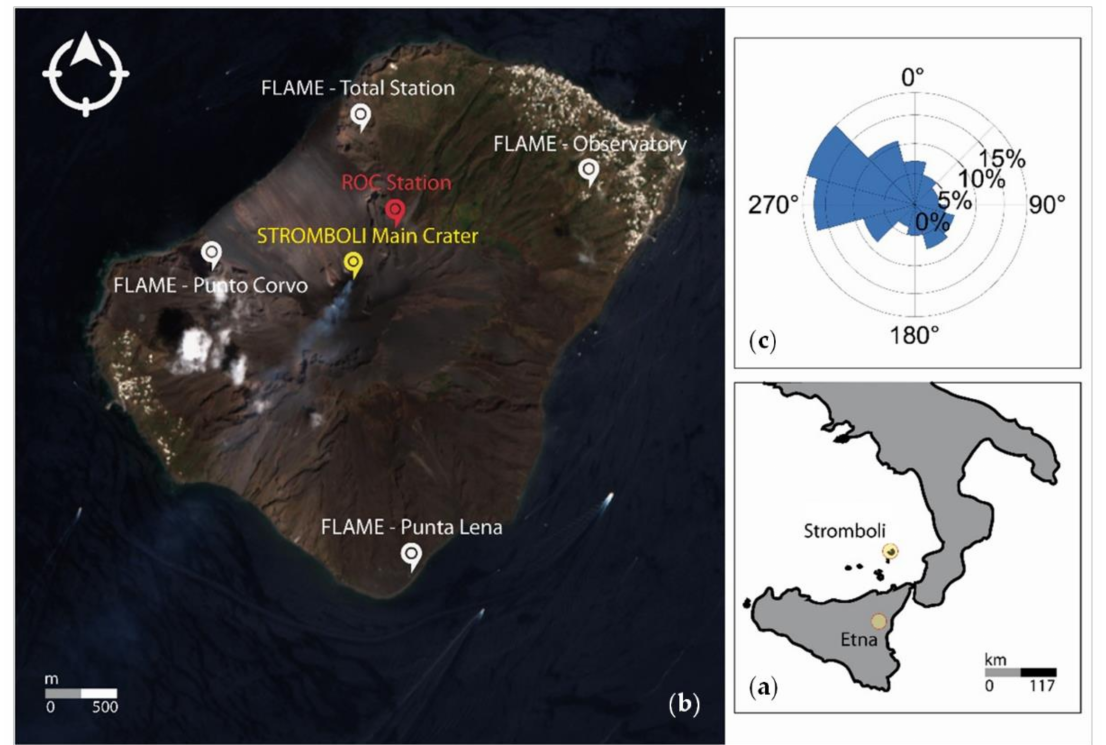
Figure 1. ( a ) Location of the Stromboli volcano in southern Italy and ( b ) satellite overview of the volcano edifice from Copernicus Sentinel-2 optical imagery acquired on 11 August 2019. The placemarks indicate: the main crater (38.79 ◦ N, 15.21 ◦ E) and five ground sensors belonging to the FLAME (white) network and ROC (red) station, respectively [14,15]. ( c ) Wind frequency rose at the 100 m reference height above ground level, estimated using measurements from the Energy Sector Management Assistance Program (ESMAP) campaigns and ECMWF Reanalysis v5 (ERA5) long-term reference data (source: https://globalwindatlas.info/; accessed on 1 October